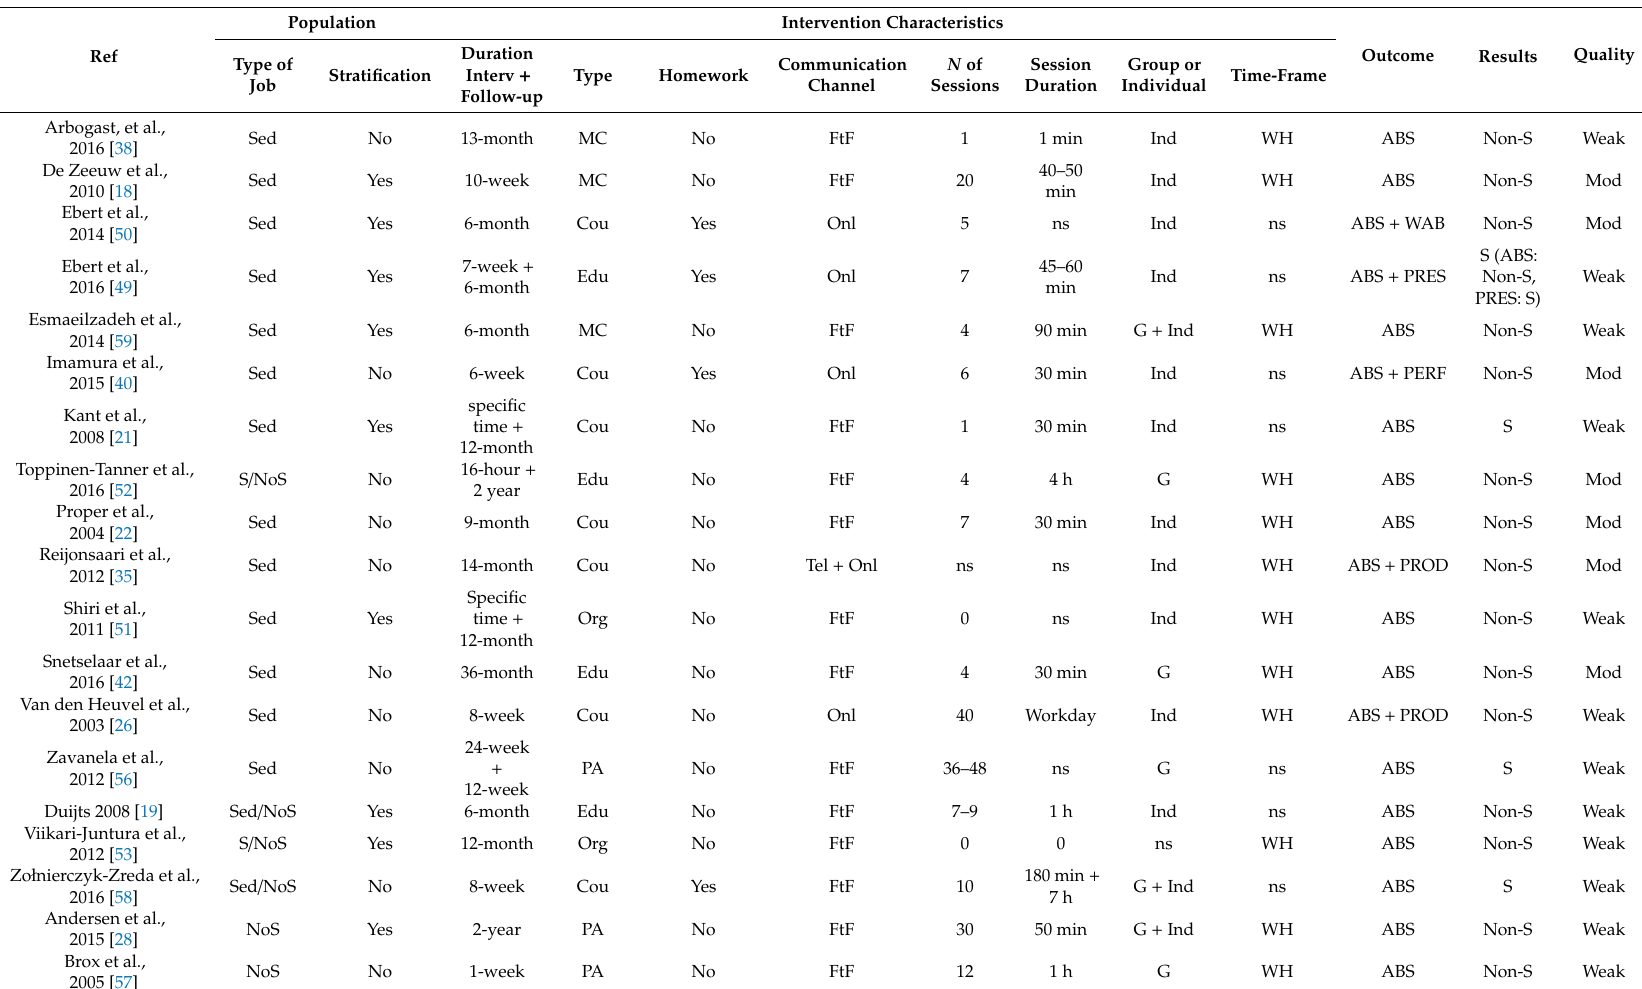
Outcome Results Quality Type of